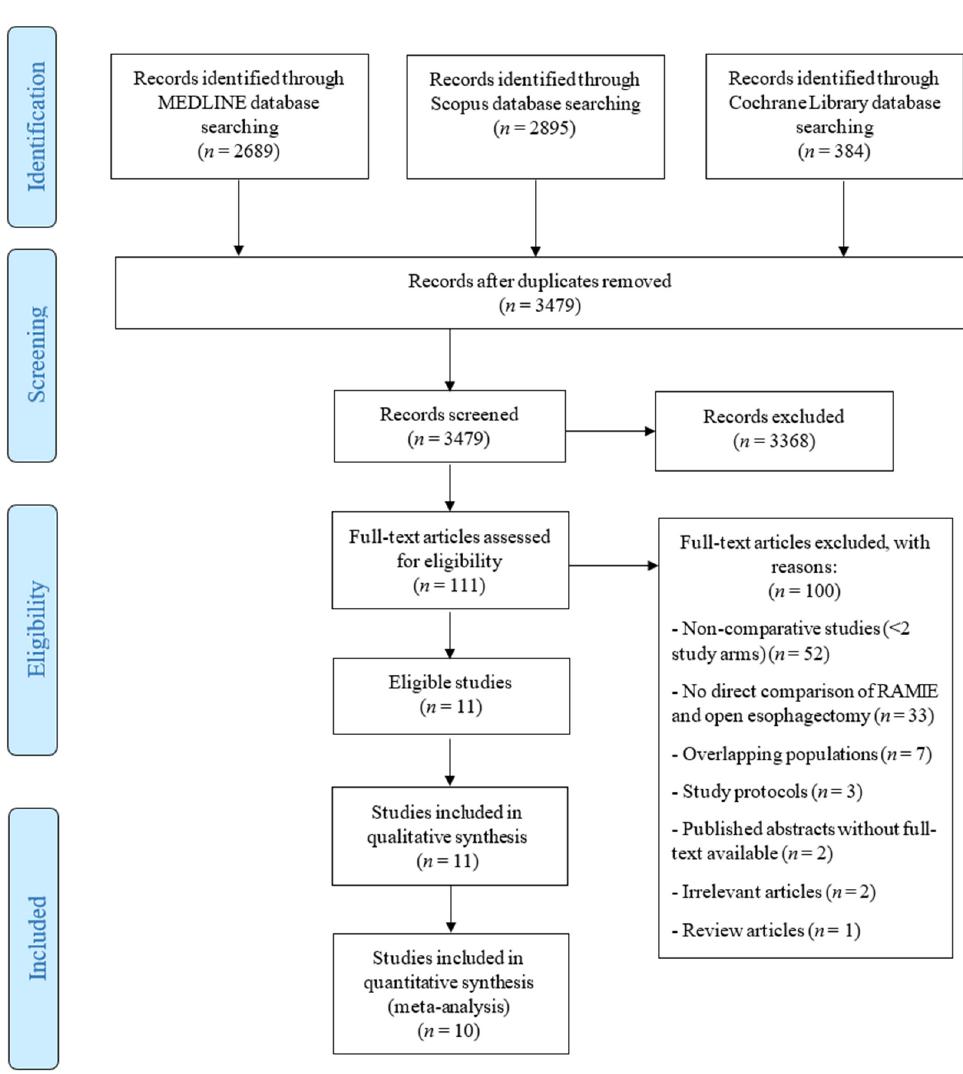
Figure 1. Preferred Reporting Items for Systematic Reviews and Meta-Analyses (PRISMA) flow diagram of the study selection process.